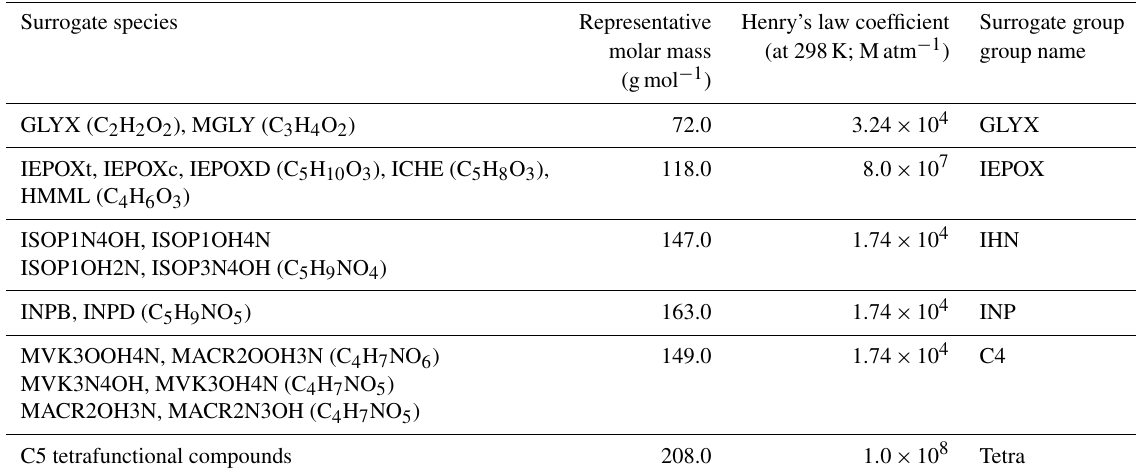
Table 3. Properties of the six new iSOA surrogate groups in FORCAsT 2.0. The Henry’s law constants below are from Sander (2015) and Safieddine et al. (2017) at 298K. Temperature dependence of Henry’s law constants is included in FORCAsT. Surrogate species Representative Henry’s law coefficient Surrogate group molar